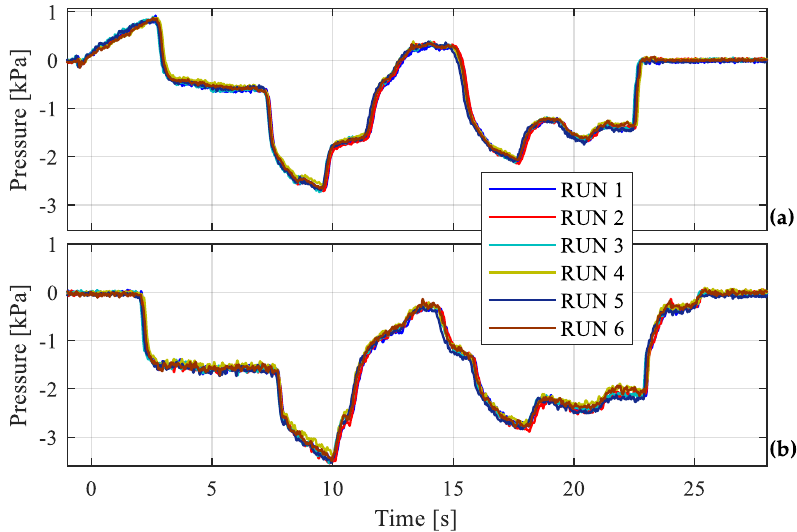
Figure 12. Comparison between the pressure acquired on-board of the sealed train in the same position in six different runs; ( a ) first car, ( b ) last car.